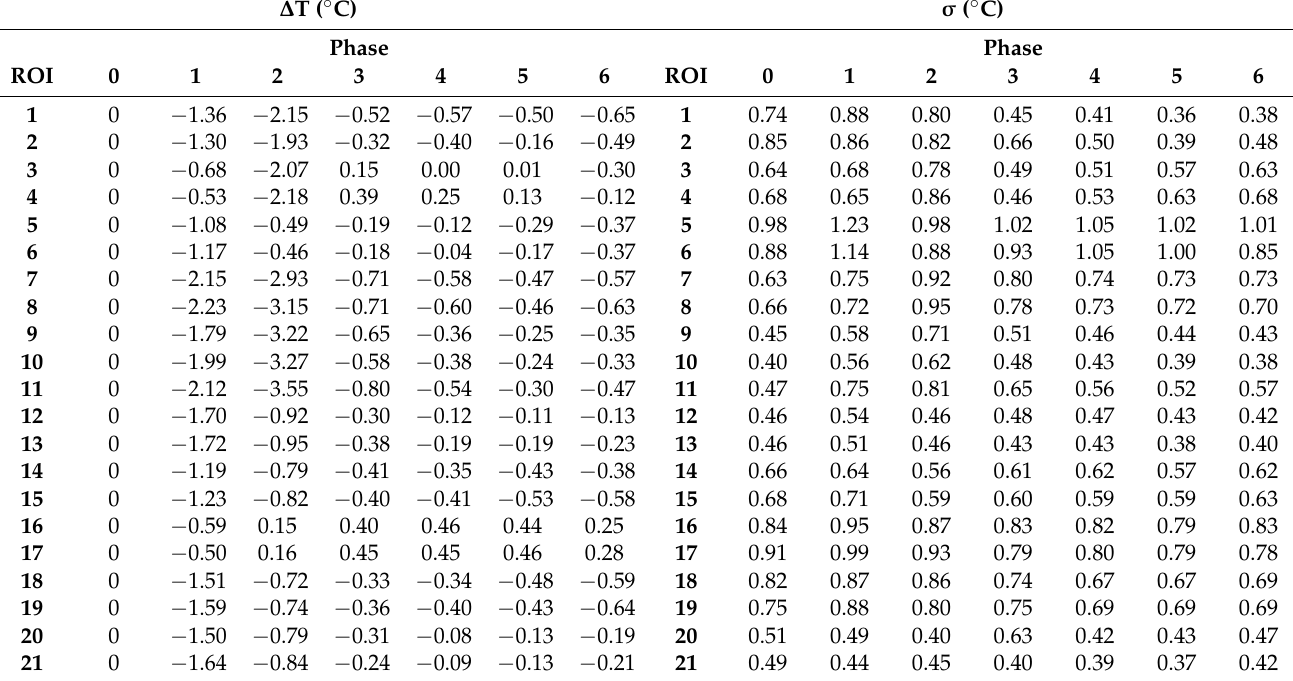
Table 2. Normalised temperature changes in the group of